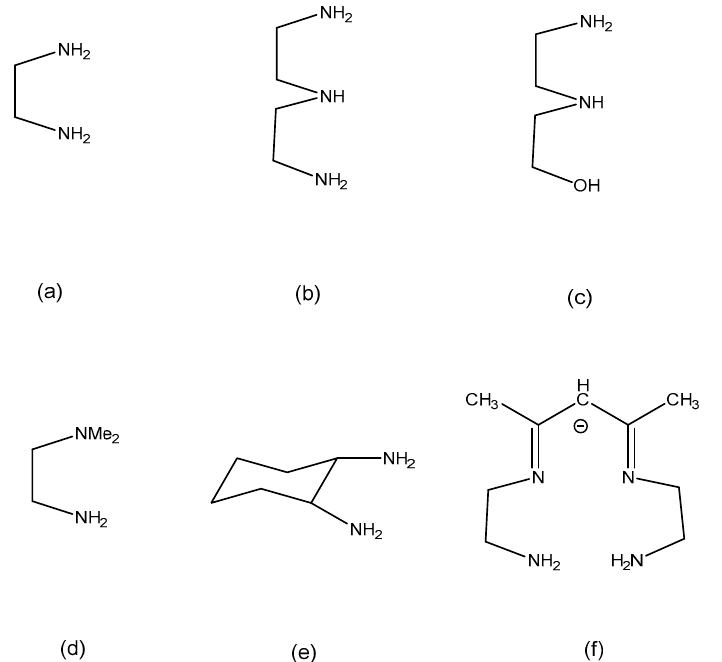
Figure 1. Drawings of the organic ligand structures found in compounds 1 – 8 with abbreviations as follows: ( a ) en, 1,2-diaminoethane), ( b ) dien, N -(2-aminoethyl)-1,2-ethanediamine, ( c ) HEen, N -(2-hydroxyethyl)-1,2-diaminoethane, ( d ) dmen, N , N -dimethyl-1,2-diaminoethane, ( e ) dach, 1,2-diaminocyclohexane, ( f ) AEN, 1-(3-azapropyl)-2,4-dimethyl-1,5,8-triazaocta-2,4-dienato(1-).